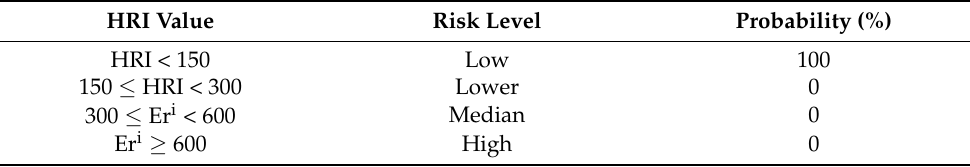
Table 9. Total ecological risk analysis results of the studied